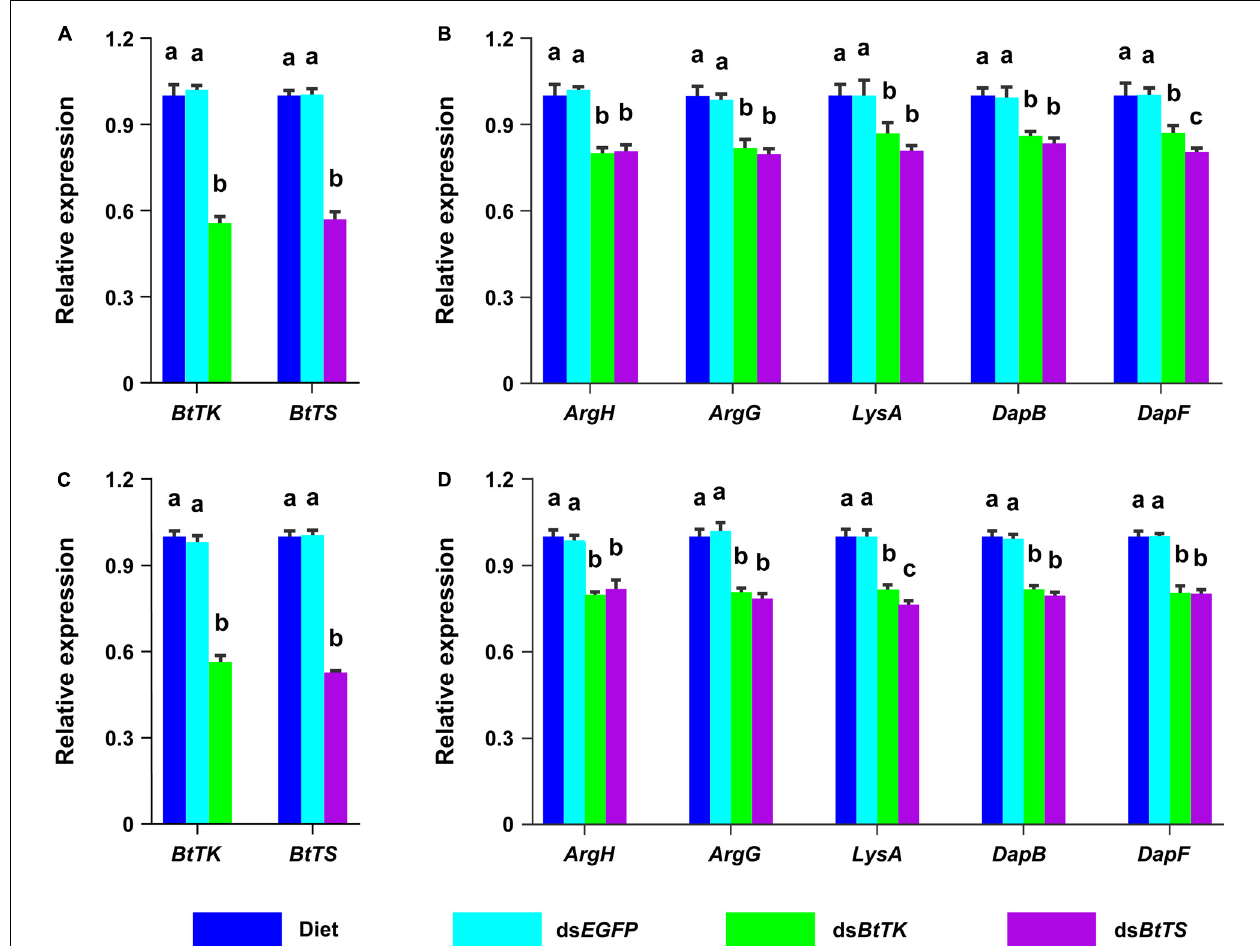
FIGURE 4 | Temporal expression profiles of BtTK , BtTS , and EAA biosynthetic HTGs in B. tabaci MED treated with dsRNA or artificial diet. (A) Expression profiles of BtTK and BtTS in B. tabaci MED that had been treated for 2 days with RNAi constructs. (B) Expression profiles of EAA biosynthetic HTGs in B. tabaci MED after 2 days of treatment. (C) Expression profiles of BtTK and BtTS in B. tabaci MED after 4 days of treatment. (D) Expression profiles of EAA biosynthetic HTGs in B. tabaci MED after 4 days of treatment. For each gene, transcript levels in group of adults fed the artificial diet were normalized to one. The values shown are the means and standard errors, and the different letters indicate treatment differences at p < 0.05 (one-way ANOVA with Tukey’s test).